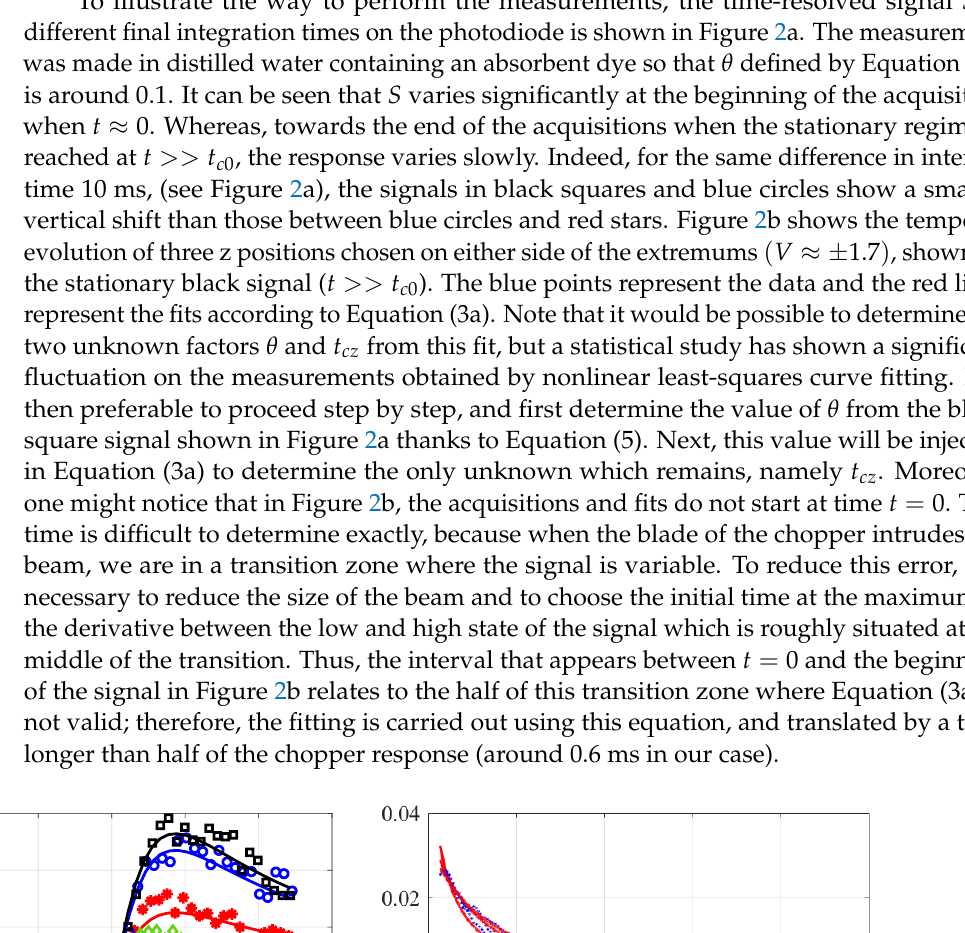
Figure 1. Scheme showing the different position of the optical elements. The cell is scanned along the beam direction around the focal plane (z = 0). The labels refer to: lens (L 1 , L 2 ), beam splitter (BS), chopper (Ch), computer (Cp) and photodiodes (PD1, PD2).